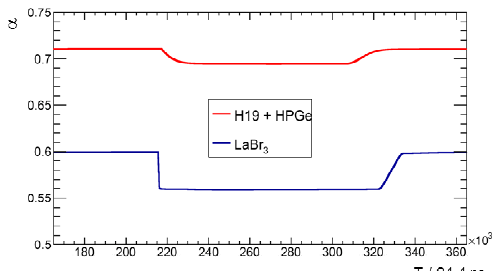
Figure 3. ToF dependent dead time of the two data acquisition systems.